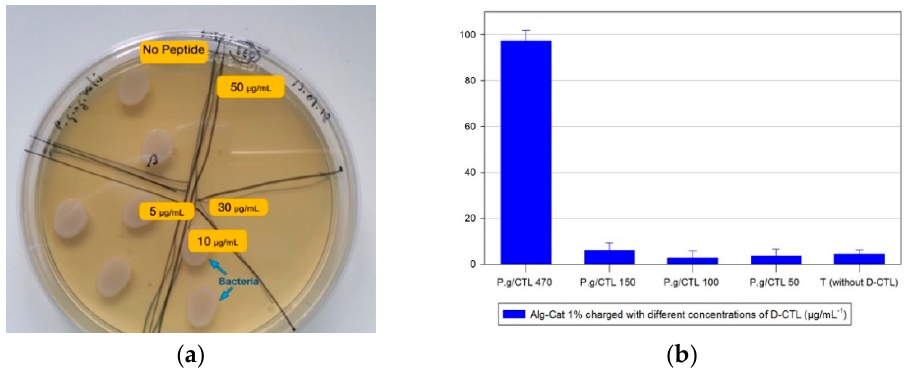
Figure 3. Determination of the MIC of D-CTL against P. gingivalis. ( a ) The MIC of D-CTL in water was estimated to be 30 µg·mL − 1 (no recontamination); ( b ) percentage of P.gingivalis (P.g) inhibition when bacteria is in contact with gel. The efficient concentration of D-CTL inside gel is 470 µg·mL − 1 at more than 24 h (3 mg·mL − 1 from the stock solution).